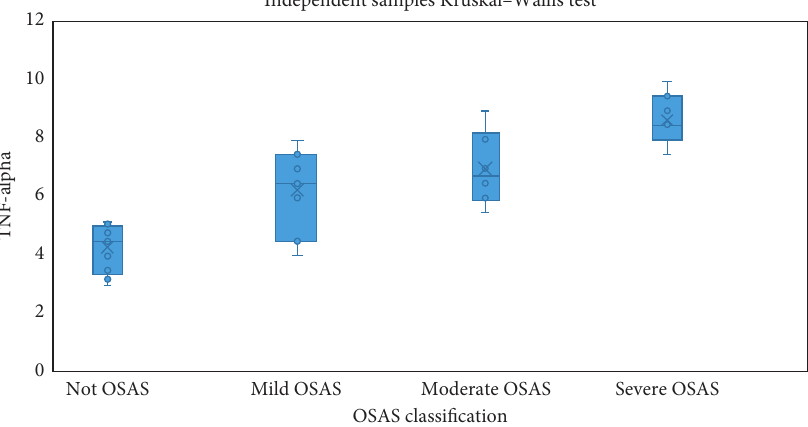
Figure 4: Distribution of TNF-alpha values according to OSAS